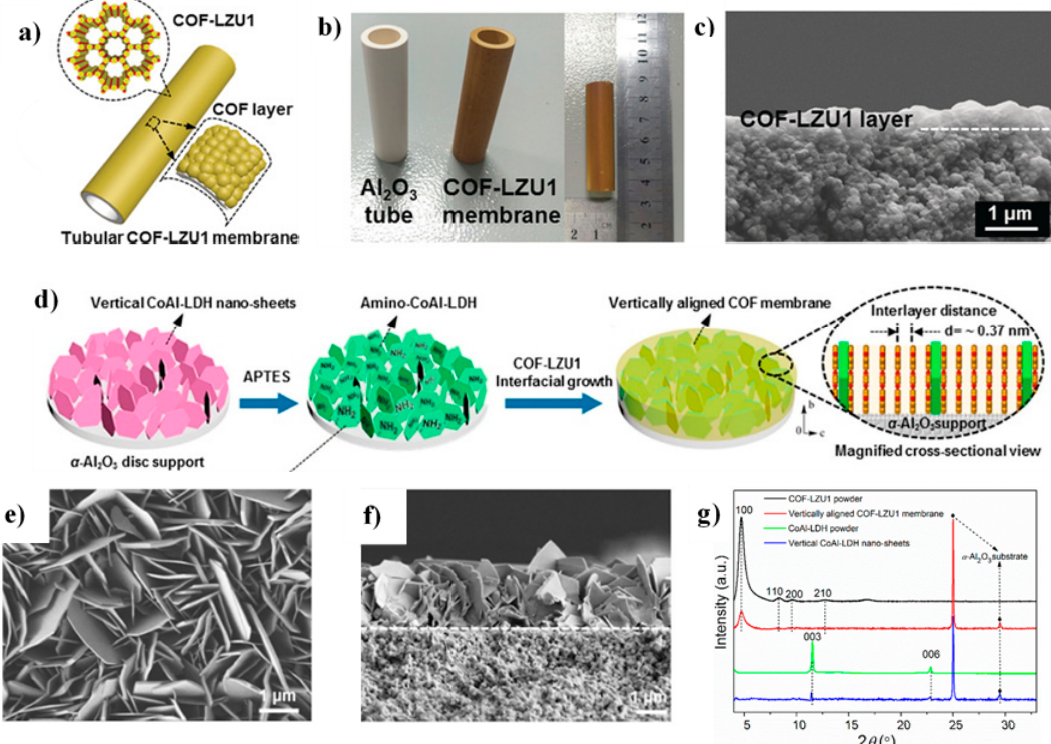
Figure 6. ( a ) Tubular COF-LZU1 membrane; ( b ) photographs of an untreated Al 2 O 3 tube and a tubular COF-LZU1 membrane; ( c ) cross-sectional SEM image of a tubular COF-LZU1 membrane; ( d ) schematic illustration of the vertically aligned COF membrane; top-view ( e ) and cross-sectional ( f ) SEM images of the CoAl-LDH layer consisting of vertically oriented nanosheets; ( g ) PXRD patterns of the powders and membranes. ( a – c ) Reprinted with permission from [44]. Copyright (2018) Wiley-VCH Verlag GmbH and Co. KGaA, Weinheim. ( d – g ): Reprinted with permission from [45]. Copyright (2020) American Chemical